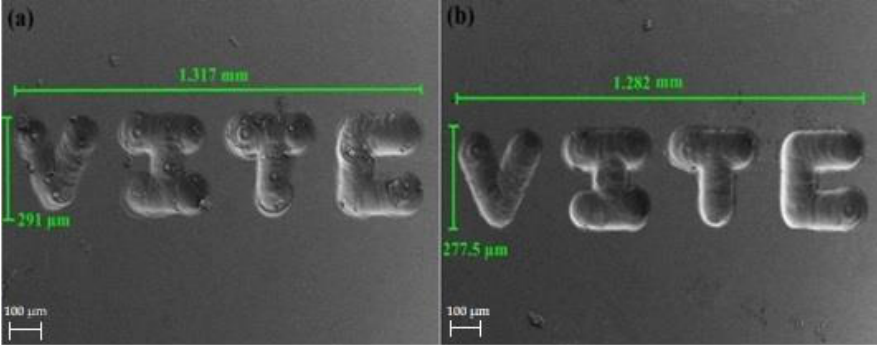
Figure 7. SEM image of a pattern fabricated using an 80 µm tool with a machining voltage of 24 V at two different working gaps: ( a ) 5 µm and ( b ) 2 µm .